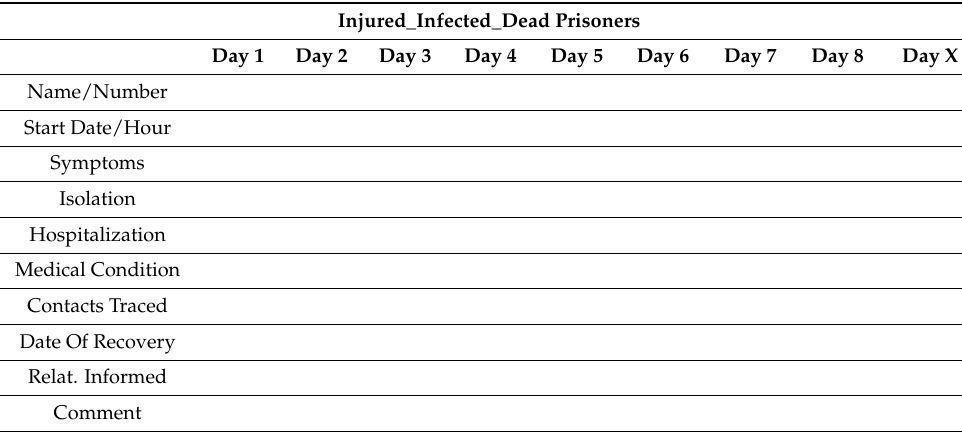
Table 6. A checklist to record the epidemiological data for inmates.